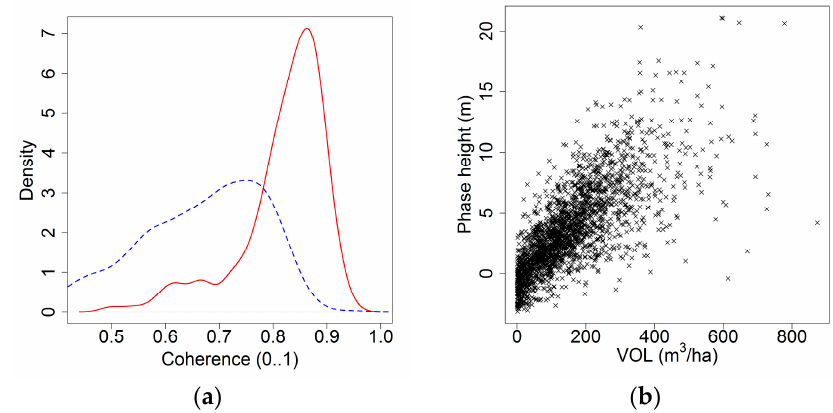
Figure 10. ( a ) Plot density of the NFI plots with regard to the coherence γ . Forest (> 80 tons/ha, dashed blue) and open ground (< 10 tons/ha; solid red). ( b ) Scatter plot of uncorrected phase height against VOL.